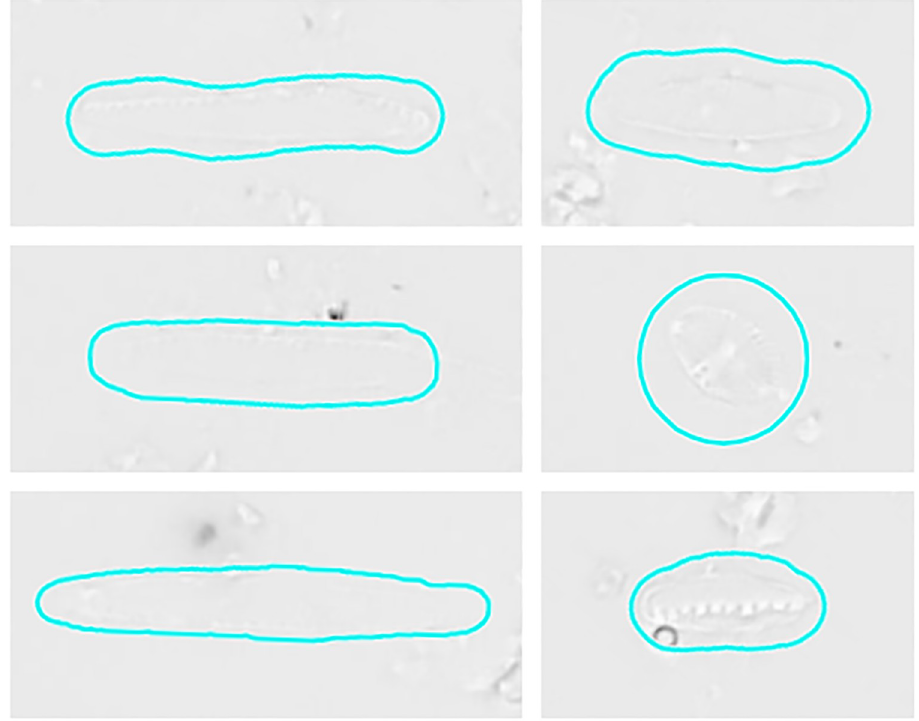
Fig 12. Examples of relevant diatom objects which had been overlooked by human annotators due to their poor contrast, but were found by our segmentation models during preliminary tests. For illustration purposes objects are marked very roughly by cyan outline, which is not their actual annotation ground